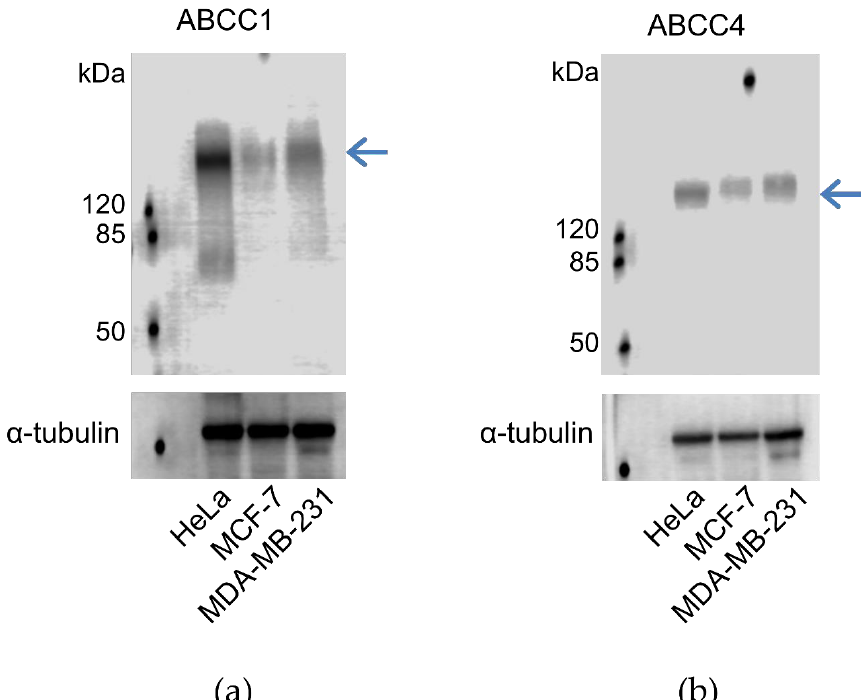
Figure 1. ABCC1 and ABCC4 are both expressed in MCF-7 and MDA-MB-231 breast cancer cells. Membrane extracts (80 µ g protein / well) from MCF-7 and MDA-MB-231 cells were assayed by Western blot for the expression of ( a ) ABCC1 or ( b ) ABCC4, alongside Hela cells as a positive control. ABCC1 was detected using the anti-MRP1 EPR4658 antibody (1:1000). ABCC4 was detected using the anti-ABCC4 M 4 I-10 antibody (1:100). The blue arrow indicates the band corresponding to ABCC1 ( a ) or ABCC4 ( b ). Comparable sample loading was monitored afterwards using the anti-tubulin primary antibody. Uncropped images can be found in Figure S3.